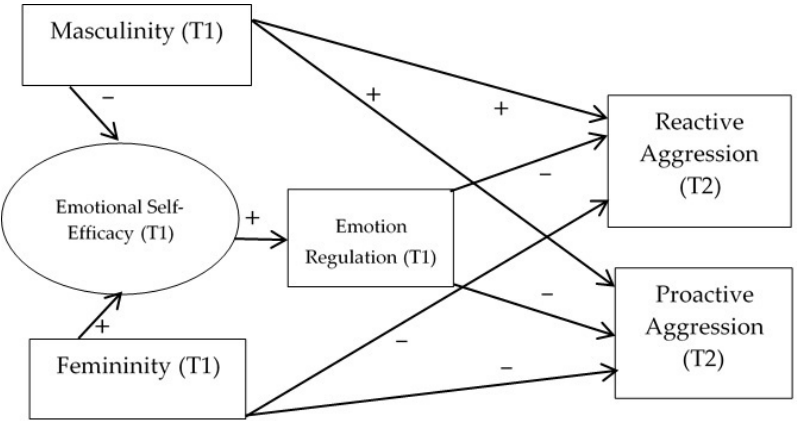
Figure 1. Starting theoretical model (+ = positive relationship; − = negative relationship). T1 = Time 1; T2 = Time 2. Emotional Self-Efficacy = Regulatory Emotional Self-Efficacy. T2 = Time 2. Emotional Self-Efficacy = Regulatory Emotional